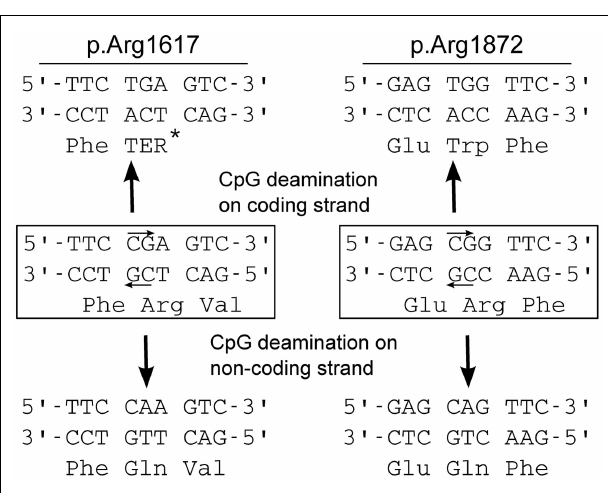
FIGURE 1 | Positions of missense mutations of SCN8A in epileptic encephalopathy . The four homologous domains of Na v 1.6 (DI to DIV) each contain six transmembrane segments (S1 to S6). The large inter-domain cytoplasmic loops 1 and 2 are evolutionarily less